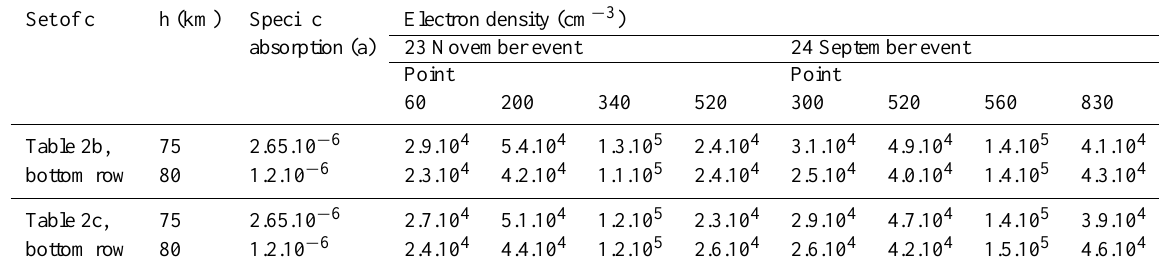
Table 4. Estimated electron densities (cm − 3 ) at 75 and 80km for the events and times used in Table 3. Set of c h (km)